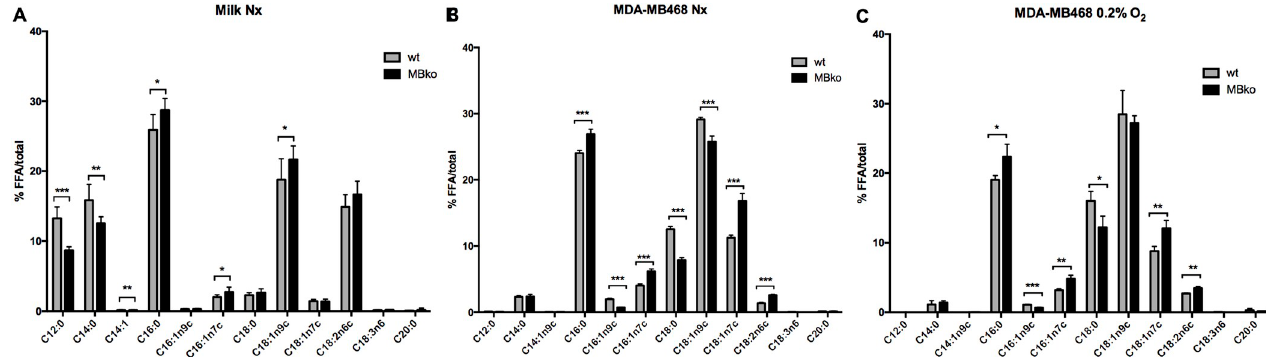
Fig 1. MB-dependent fatty acid profiles. Fatty acid profiles (C12-C20) of total lipids of the mouse milk ( A ), MDA-MB468 breast cancer cells cultured under normoxia (Nx, B ) and severe hypoxia (0.2% O 2 , C ). In all graphs, MBwt as grey bars vs MBko black. FA levels are depicted as “% of FA / total FA pool”. Students t-test was used for statistics (n = 4–8); mean ± SD. � p � 0.05, �� p � 0.01, ��� p � 0.001. The axis is labelled FFA.